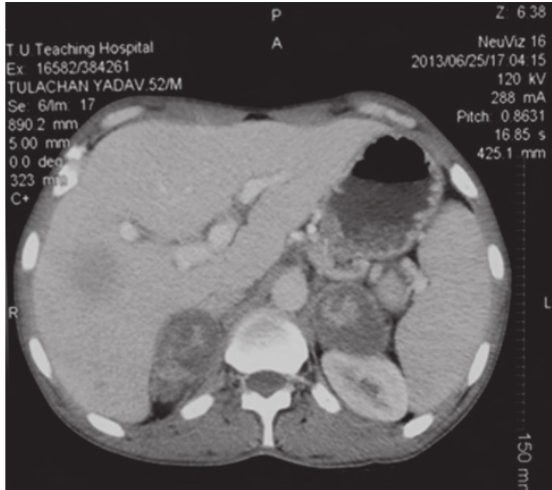
Figure 1: Heterogenous enhancing bilateral adrenal masses